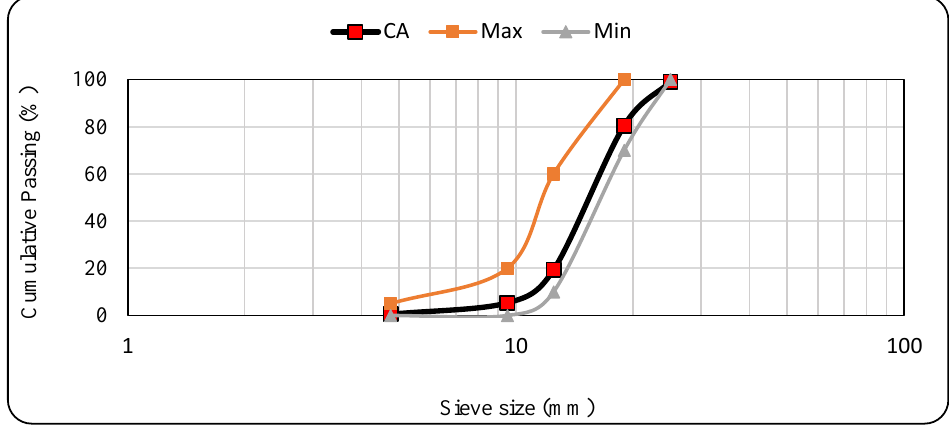
Figure 2. Particle size distribution of coarse aggregate (CA) and BS EN 933-1:1997 limits. Table 4. Properties of PEG-400 (Source: alpha-chemika, 2019).